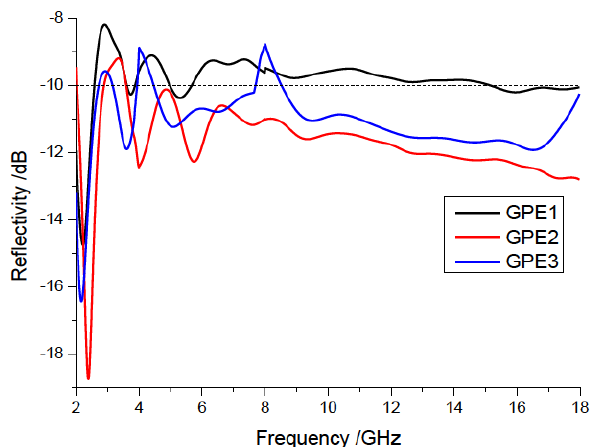
Figure 6: The absorbing reflectivity of GPE1~GPE3